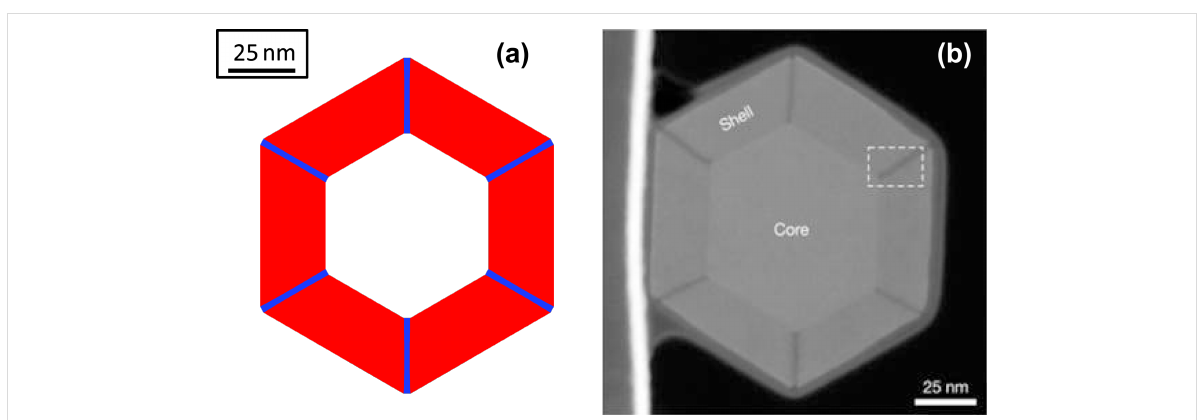
Figure 5: (a) Cross section of the core–shell nanowire with six {112} facets (blue color) along the corners of six {110} facets (red color) in the numeri- cal simulation; the stripe structure along the directions within 25 nm of thickness of the shell. (b) The experimental result showing Al-rich stripes along the directions (dark lines) obtained in [3].